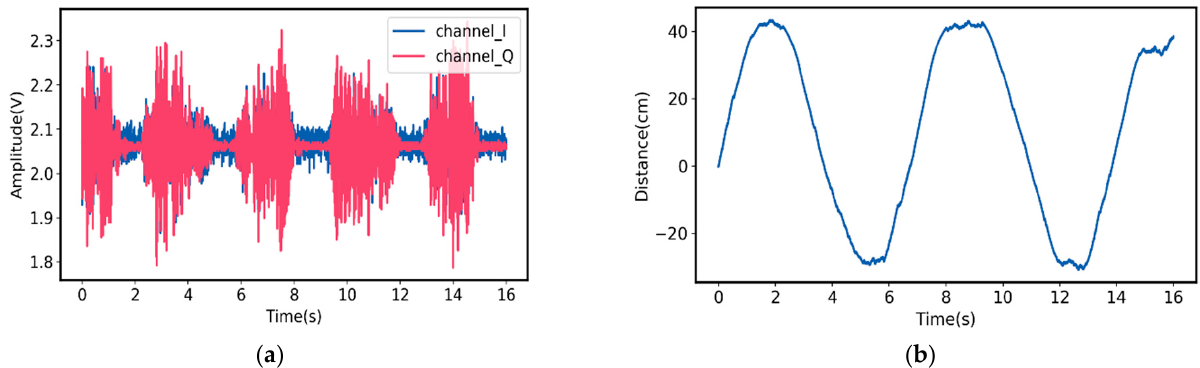
Figure 12. ( a ) Measured I- and Q-baseband signals for Target B motion at 26.3 GHz; ( b ) measured relative moving distance of Target B [50].